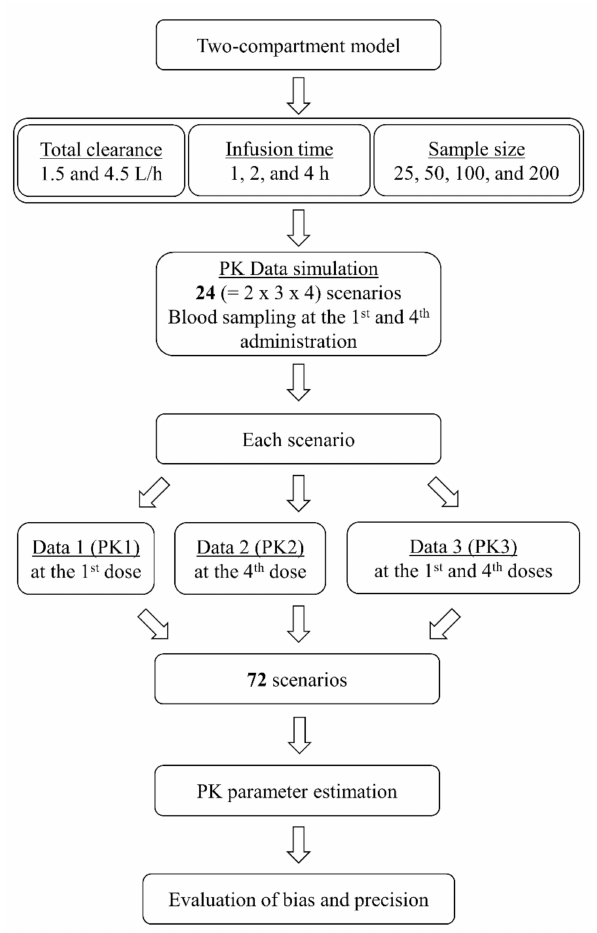
Figure 1. Flowchart for simulation and